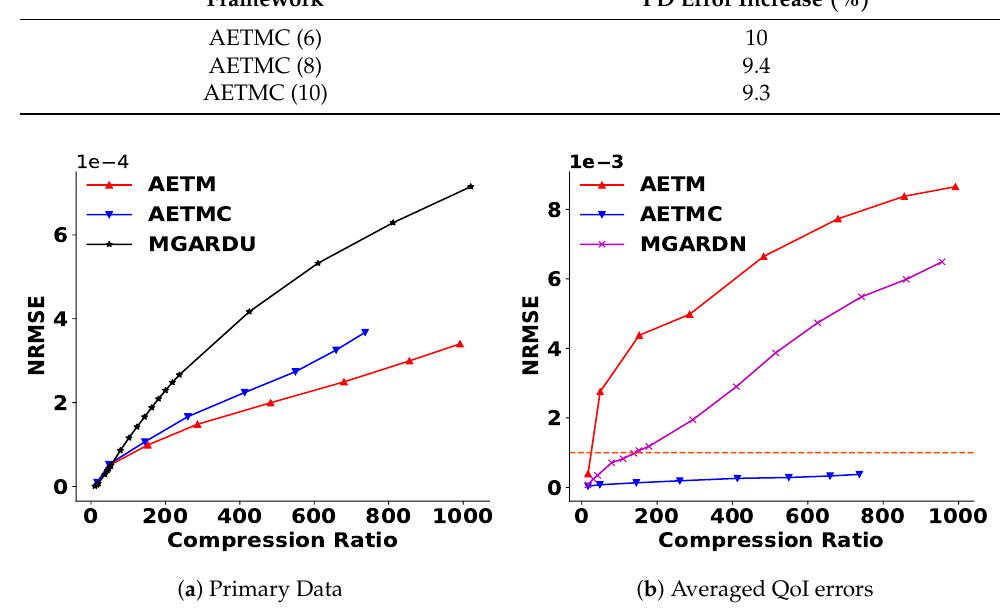
Figure 5. Comparison of PD ( a ) and the average of six QoI errors ( b ) in AETM, AETMC, and MGARD. The graphs show that AETM with constraint satisfaction (AETMC) outperforms two versions of MGARD in both PD and QoI errors. The number of bits for Lagrange multiplier quantization in AETMC is chosen to be